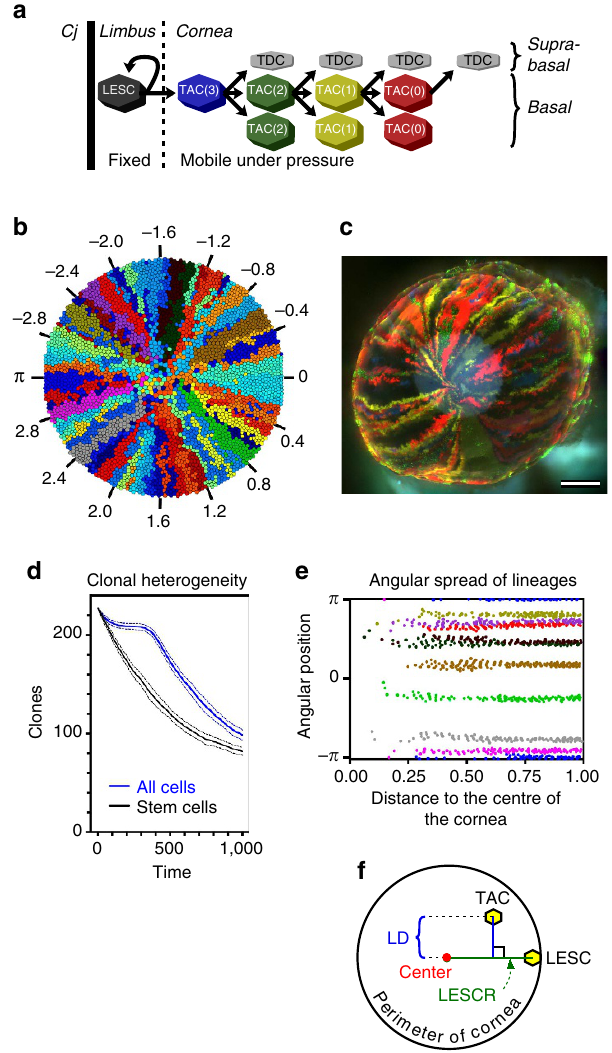
Figure 1 | A mathematical model of the corneal epithelium recapitulates centripetal migration and clonal segmentation. ( a ) A scheme of cell lineages in the cornea simulation model. The conjunctiva (Cj) forms an impenetrable perimeter. LESCs can divide either symmetrically, to produce two LESCs, or asymmetrically, to produce a LESC that is retained within the limbus and a TAC that occupies a space in the cornea immediately adjacent to the limbus. When a LESC dies, the two neighbouring LESCs are stimulated to replicate to fill the void, only one of them being able to occupy the space. TACs can divide either asymmetrically, to produce a suprabasal terminally differentiating cell (TDC) and another TAC in the basal layer, or symmetrically, to produce two TACs in the basal layer. TACs can undergo a limited number of symmetrical cell divisions, TAC(max), which is variable but typically set at 3, after which they die. The number of symmetric replications remaining for a TAC is shown in parentheses. ( b ) A representative simulation in which the replicative potential of TACs is limited to 4 symmetrical cell divisions and development has been allowed to continue for 750 iterations of the algorithm. The numbered spokes provide direction reference points (in radians) for the location of clones in e . ( c ) A fluorescence micrograph of a cornea from a K14CreERT2-Confetti mouse, injected with tamoxifen when 6 weeks old and killed 16 weeks later. The circular haze in the centre of the cornea is autofluorescence from the underlying lens. Scale bar, 500 m m. ( d ) The number of clonal lineages of all cells (blue) and only LESCs (black), plotted ± s.d. against time for 25 simulations. ( e ) The spread of cells of a lineage was plotted for 10 representative clones of the cornea shown in b . The distance is measured as a proportion of the corneal radius. The locations and mean linear displacements (LDs) of these clones are reported in Supplementary Table 1. ( f ) Calculation of the LD, a measure of the degree to which migration is centripetal. The locations of a TAC in a cornea and the LESC from which it is derived are shown. If migration of the LESC-derived lineage was perfectly centripetal, then the TAC would lie on the ray joining the position of the LESC to the centre of the cornea (the LESCR). The LD is the absolute distance of the perpendicular from the TAC to this ray. NATURE COMMUNICATIONS|7:12388|DOI: